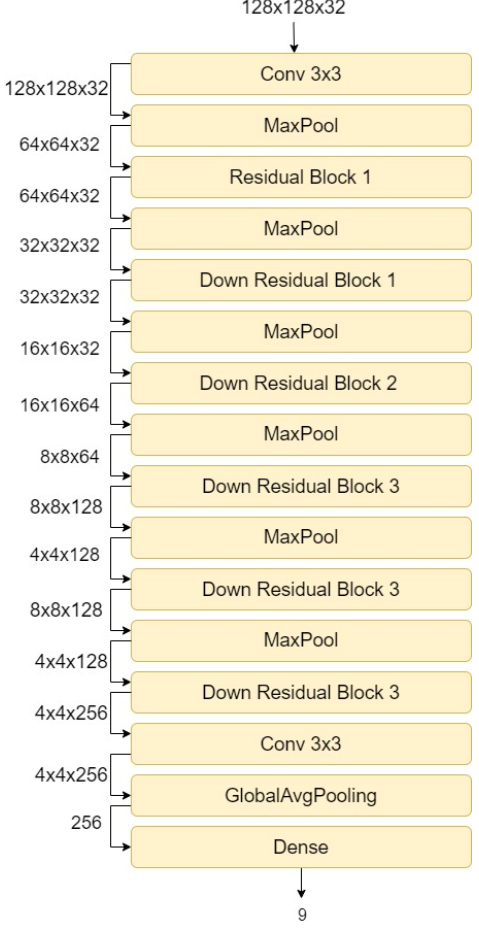
Figure 8. Improved CNN network structure for precise license plate identification.